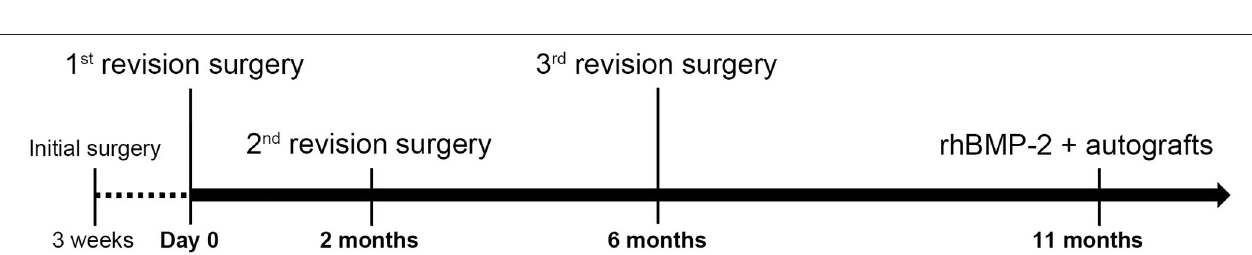
FIGURE 1 | Radiographic progression of bone non-union. (A) At the first visit, radiographs of the right hind limb show a diaphyseal comminuted fracture of the right femur with active bone callus formation and implant failure. (B) Three months after the first revision surgery, the radiographs of the right femur show implant loosening, bone shortening, and no new callus formation in the fracture gap. (C) Four months after the second revision surgery, although autogenous cancellous bone graft was applied during the surgery, implant loosening and non-union are still noted. (D) After 11 months and multiple surgical revisions, significant atrophic non-union and bone shortening are